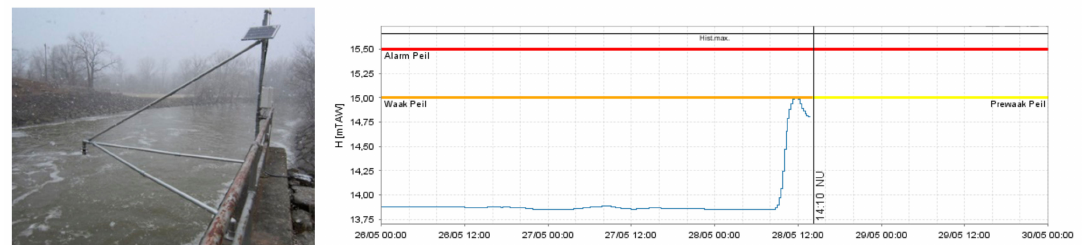
Figure 8. Ultrasonic distance sensor water level monitoring ( left ) [121] and measured water level output at Grimbergen / Maalbeek, Flanders on 28 May 2019 ( right ) [122].